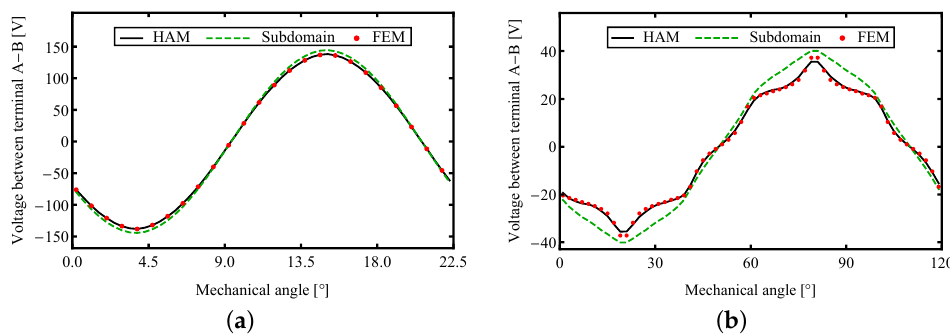
Figure 19. Comparison of back-EMF waveforms between Terminals A and B: ( a ) Machine I and ( b ) Machine II.